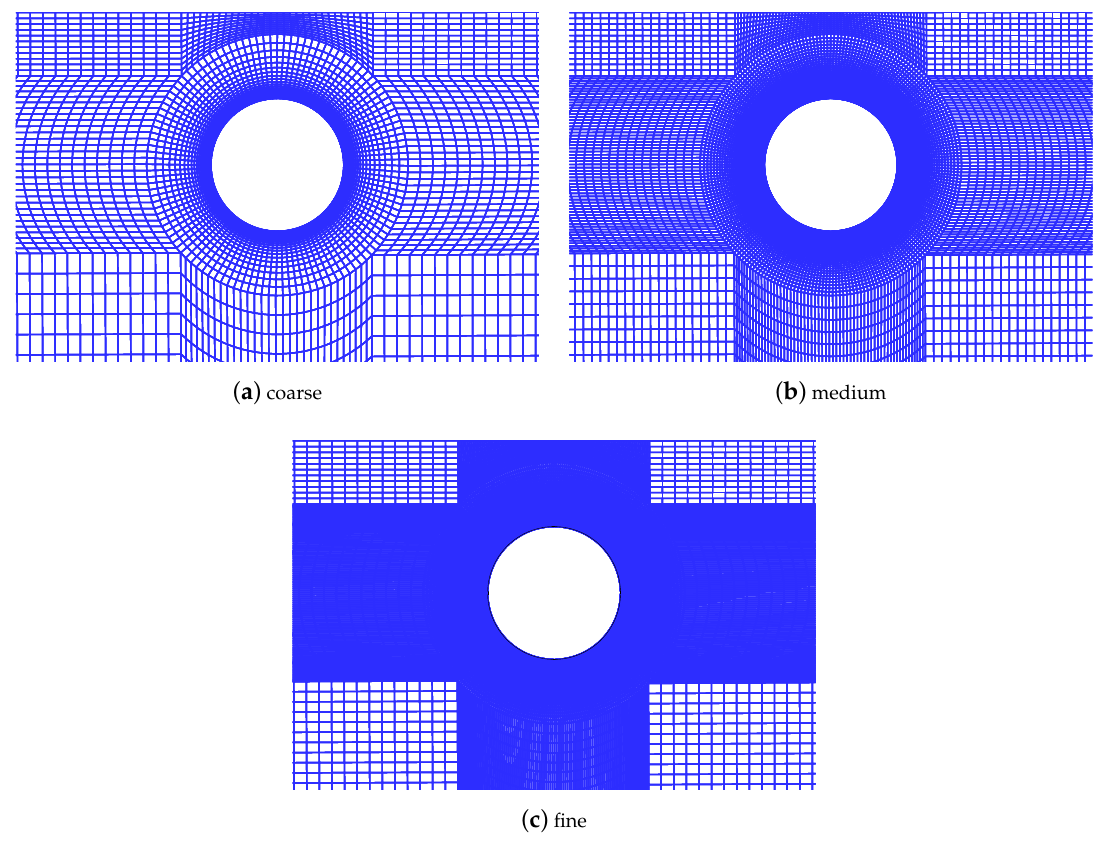
Figure 2. Different coarseness of body-fitted grids around the